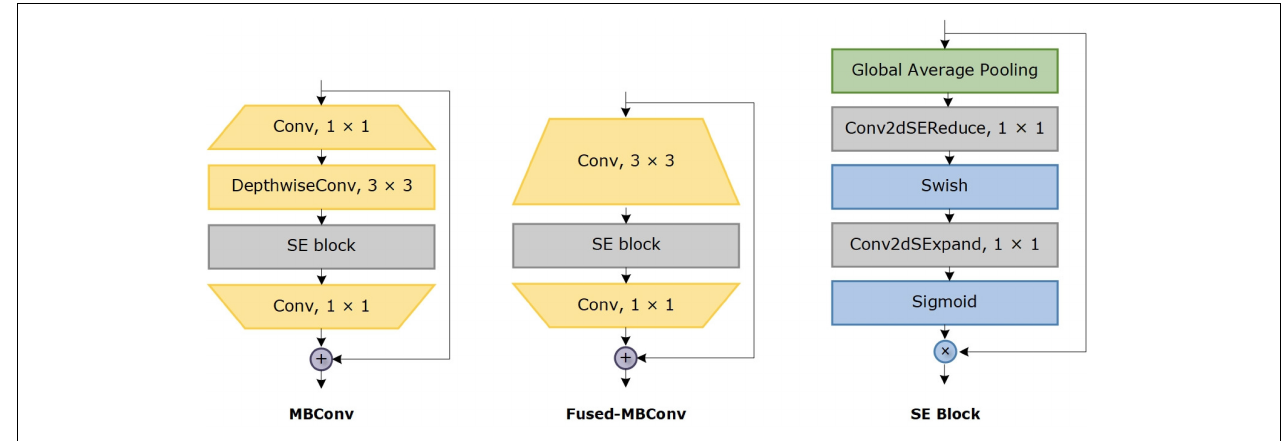
FIGURE 4 | Structural details of MBConv4, Fused-MBConv4, and SE block.